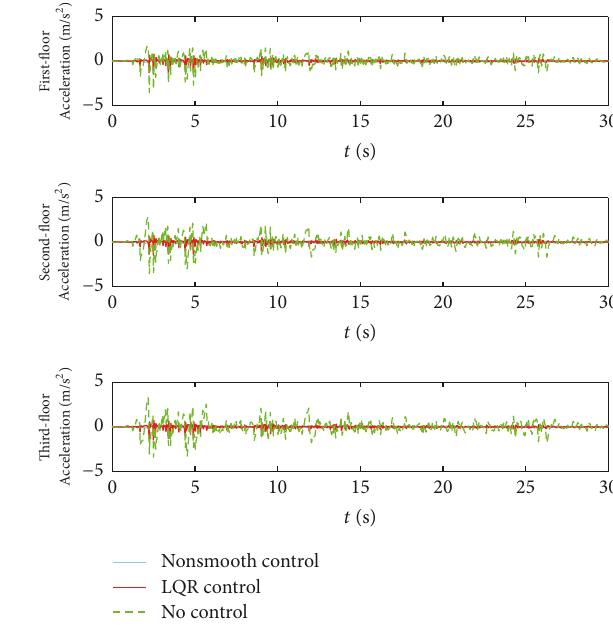
Figure 5: Control force of example 2. Figure 6: Acceleration response of example 2.